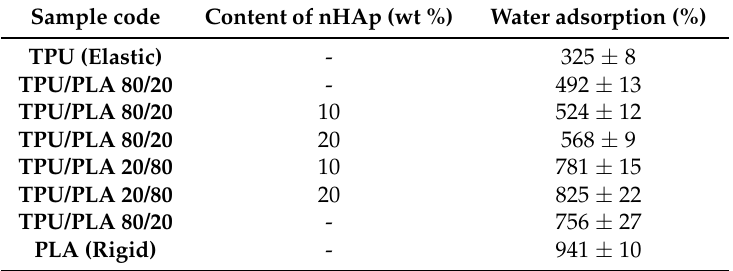
Table 6. The analysis of water adsorption of the prepared composite materials and pure TPU and PLA